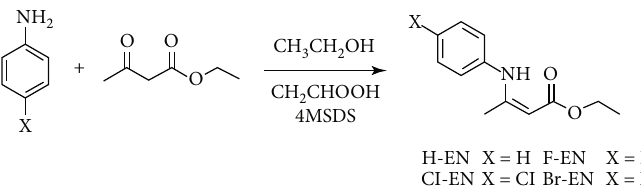
Figure 1: Synthesis of halogenated anilino- β